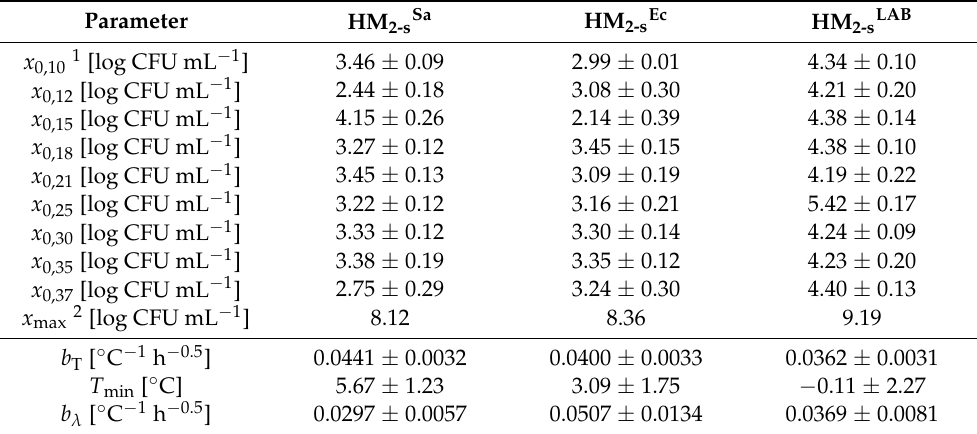
Table 1. Parameters of HM 2-S with the 95% confidence limit determined by the two-step analysis method used for the growth prediction of single cultures of S. aureus (Sa), E. coli (Ec), and Fresco (LAB) in milk.